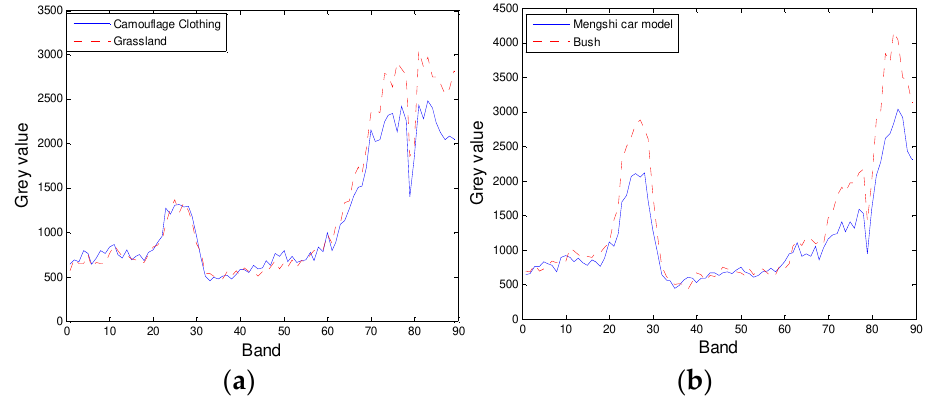
Figure 12. Spectral information curves of different objects. ( a ) Spectral information curves of Camouflage clothing and grassland. ( b ) Spectral information curves of Mengshi car model and bush.